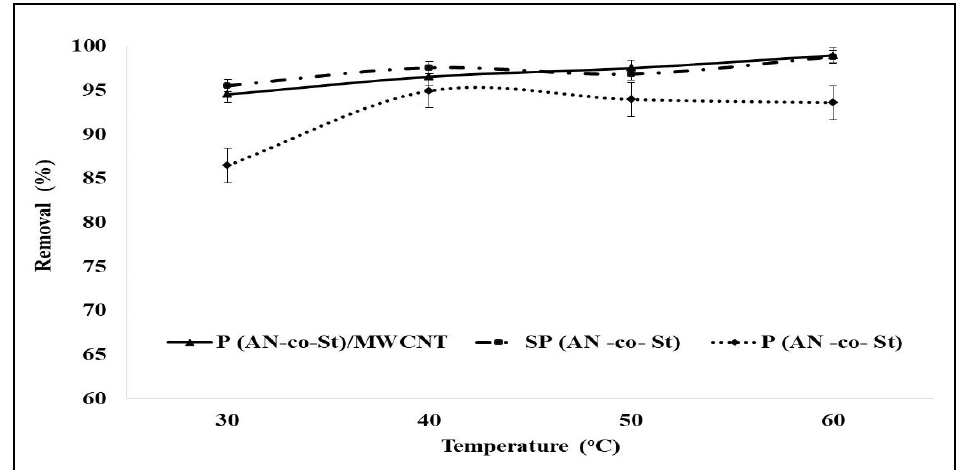
Figure 9. Effect of temperature on the adsorption of MO.